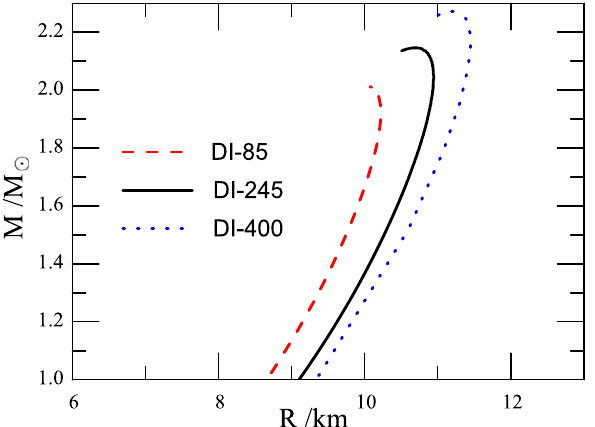
Fig. 5 (cid:2) 1 . 4 of static QSs using the transverse and radial orientations of the magnetic fields as a function of B 0 with the fast B-profile with